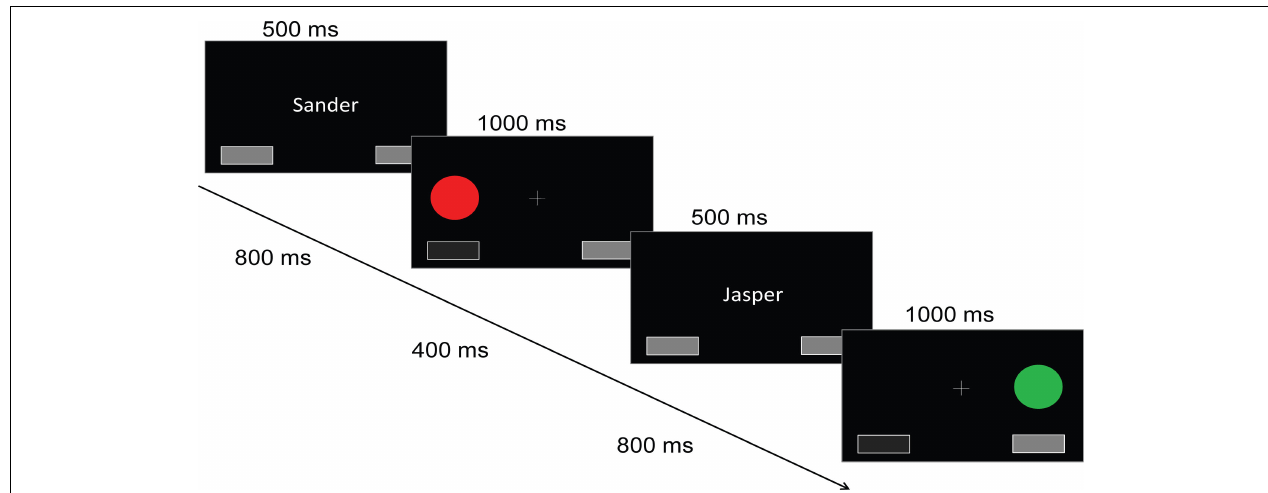
visually presented response panel was highlighted. In the other condition, one of the visually presented response panels was also highlighted indicating the other persons’ response. Four different colored circles were used that were presented either on the right or left side of the central fi xation cross, respectively. Green and red circles were mapped to a left response button press whereas yellow and blue circles were mapped to a right response button press. There were either congruent, i.e. color and spatial location overlap, or incongruent conditions, i.e. color or spatial location do not overlap. No stimulus repetitions were allowed. Cue-trial and inter-trial intervals are not depicted for sake of